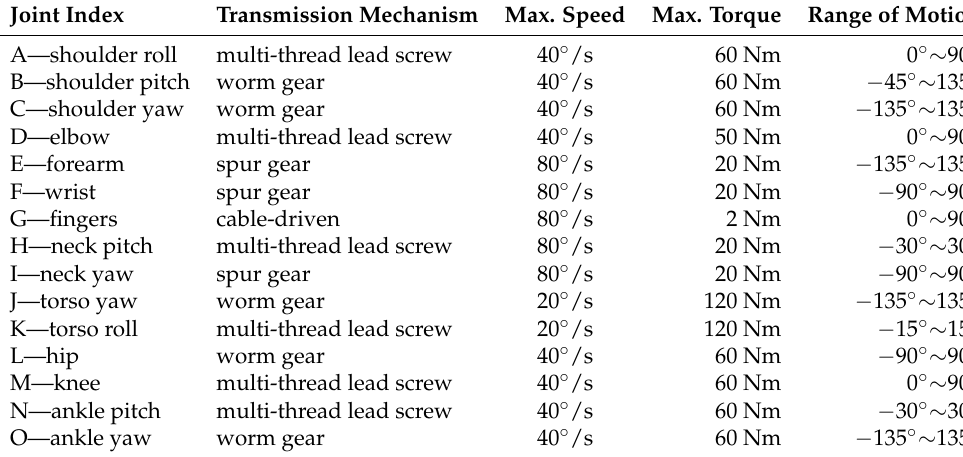
Table 1. Summary of joint specifications for